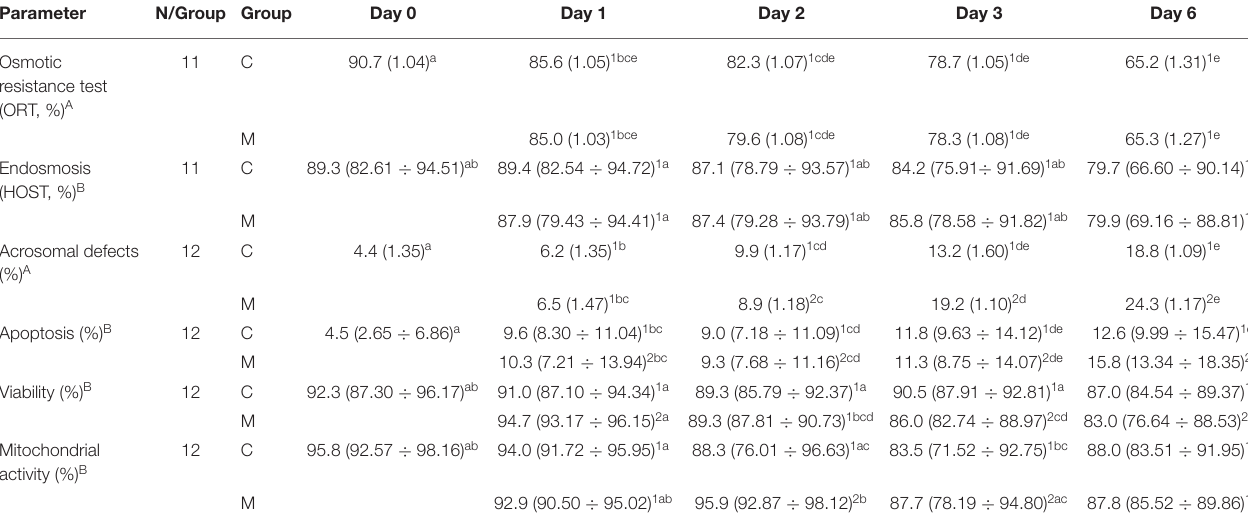
TABLE 4 | Results of semen analysis of osmotic resistance test (ORT), endosmosis (HOST), and flow cytometry parameters from semen samples collected in decreasing photoperiod during a cold storage period of 6 days.